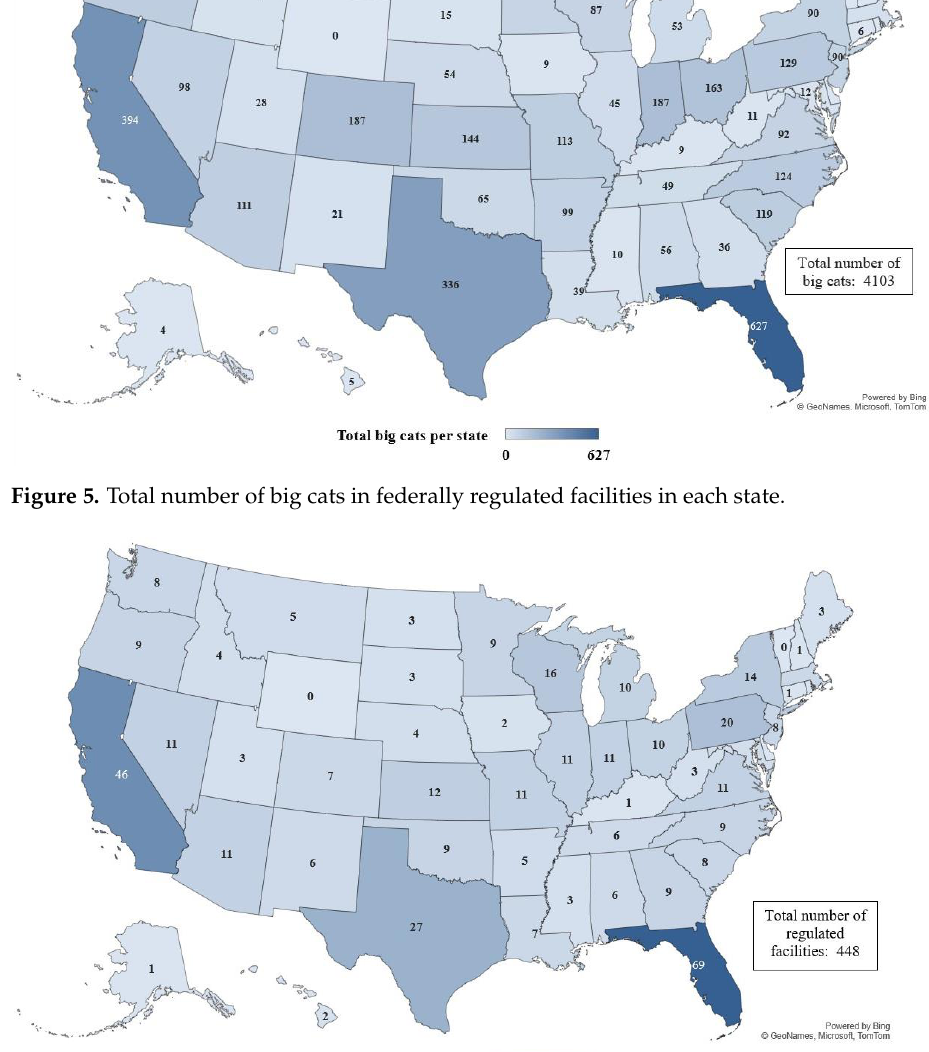
Figure 6. Total number of federally regulated facilities holding big cats in each state.